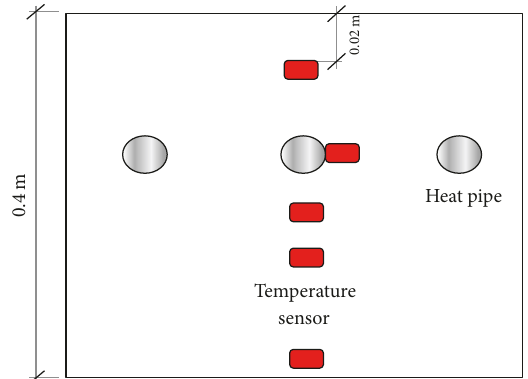
Figure 3: Temperature monitoring.